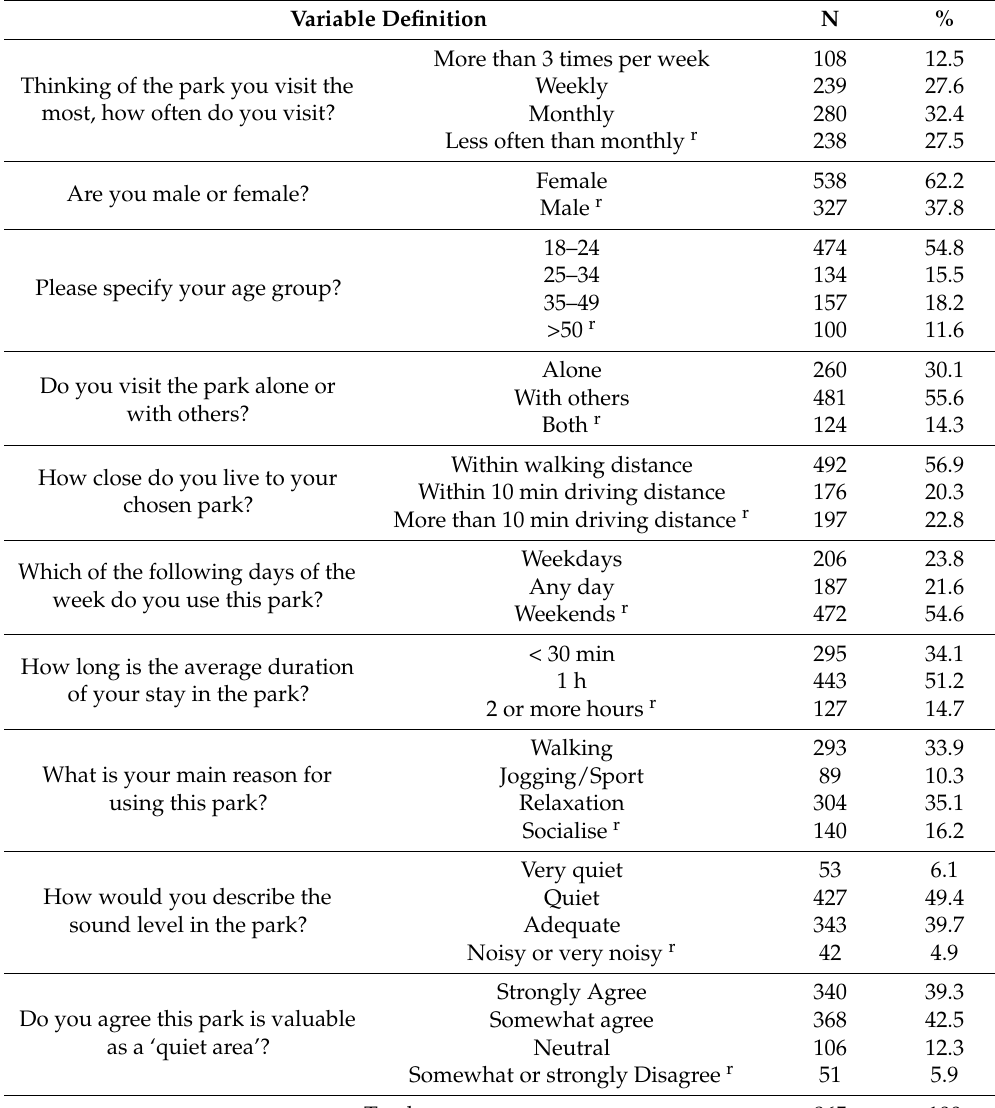
Table 1. Variable definition and